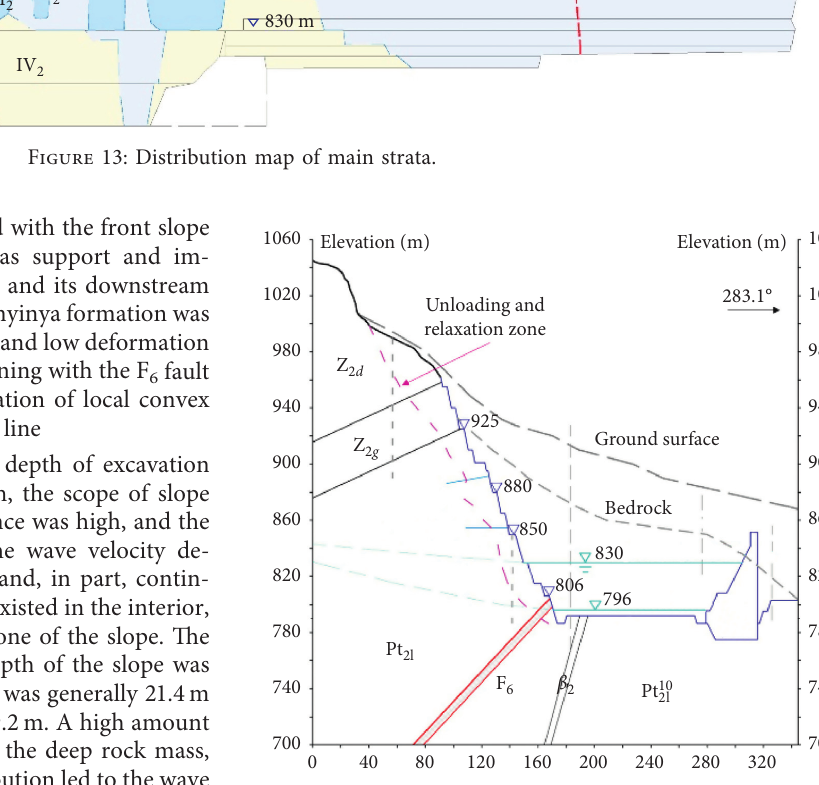
Figure 14: Unloading relaxation zone within the middle of slope.